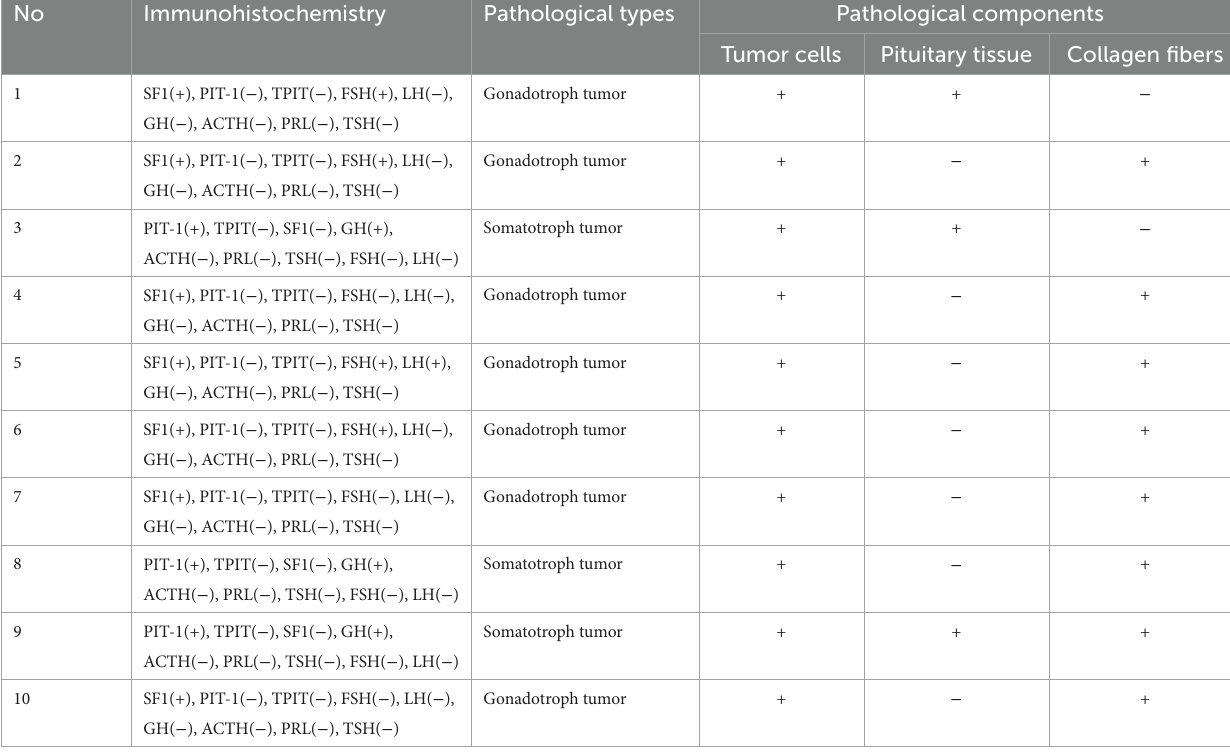
TABLE 3 Pathological types of tumors and pathological components of suspicious